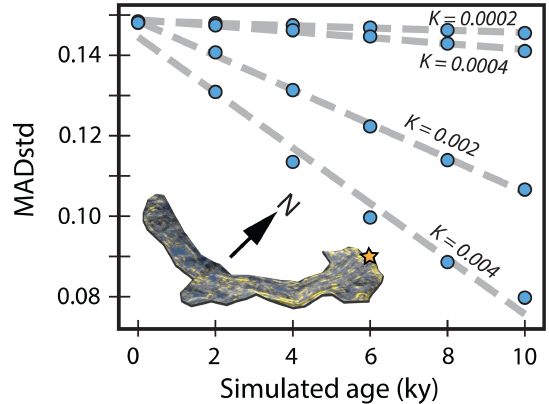
Figure 6. MADstd values for simulated diffusion across the Jun- gle Creek earthflow. Inset image shows the Jungle Creek slide with modern (simulation time = 0) MAD values where yellow are high directional MAD and blue are low. Star shows location of sam- ple 8-3-20-1. For all diffusion values, linear regressions give an R 2 of > 0 .